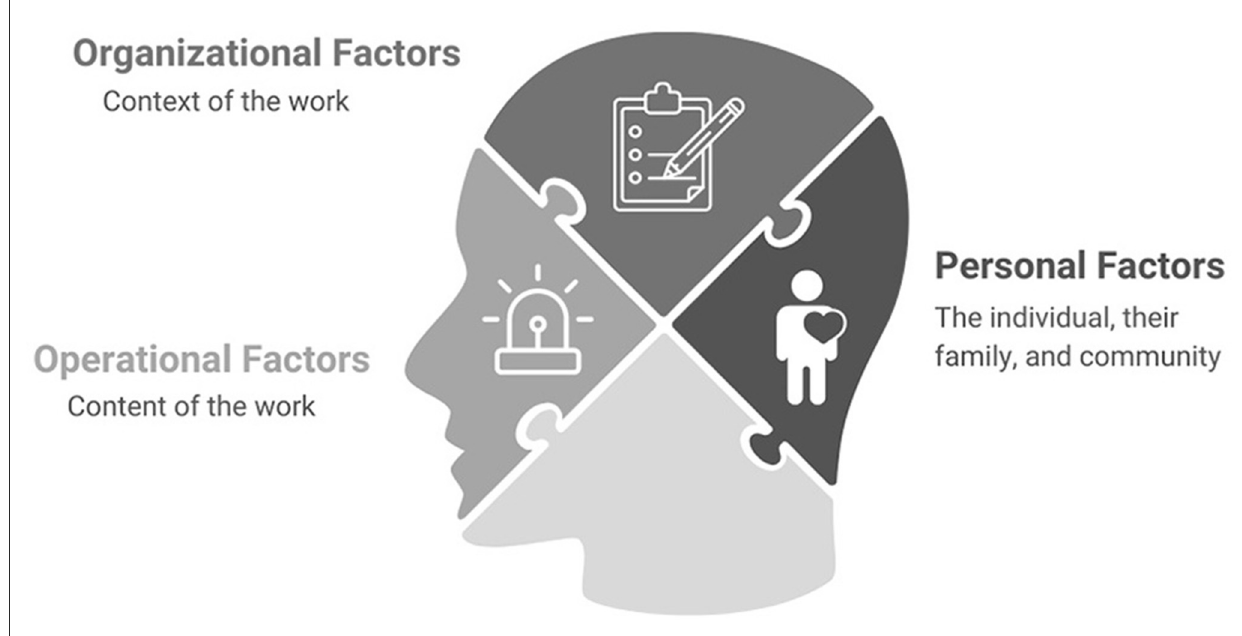
FIGURE1 TR i- O perational- O rganizational- P ersonal Factor Model